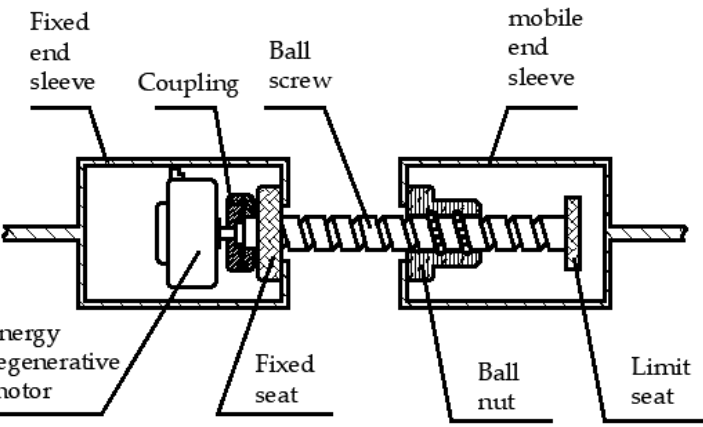
Figure 4. Structure of the 1/4 energy regenerative active suspension.